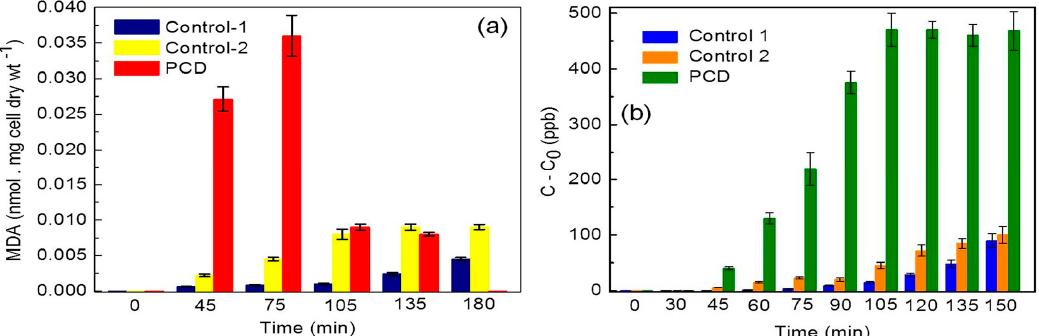
Figure 39. Plots of ( a ) malondialdehyde (MDA) content vs time and ( b ) leakage of K + ion vs time for MDR E. coli treated with Fe/ZnO NPs. Initial MDR E. col i concentration = 1.2 × 10 7 CFU/mL, Temperature = 35 ± 2 °C, pH = 6.5, [Fe/ZnO NPs] = 500 mg/L. Error bars indicate standard deviation of replicates ( n = 3). Reproduced from [306] under a Creative Commons Attribution 4.0 International License.